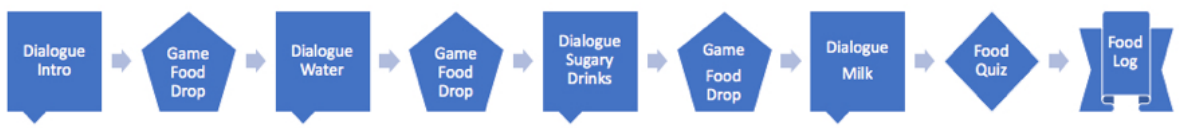
Figure 3. Foodbot Factory game flow diagram for Drinks